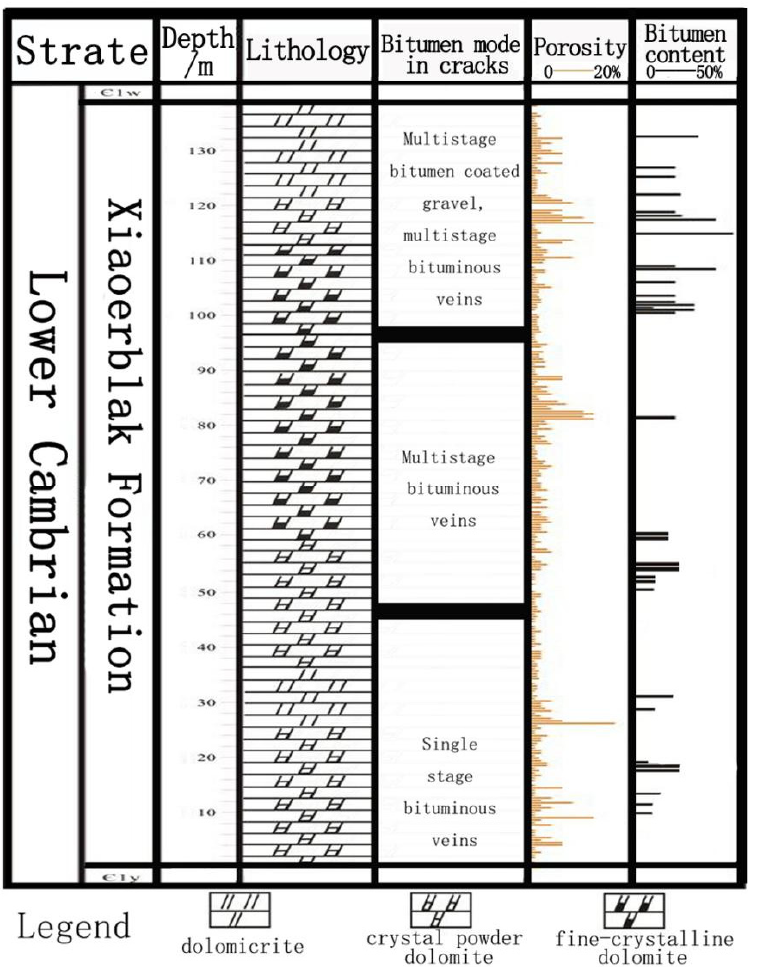
Figure 10. Comprehensive bitumen display in the Lower Cambrian in Shihuiyao section.